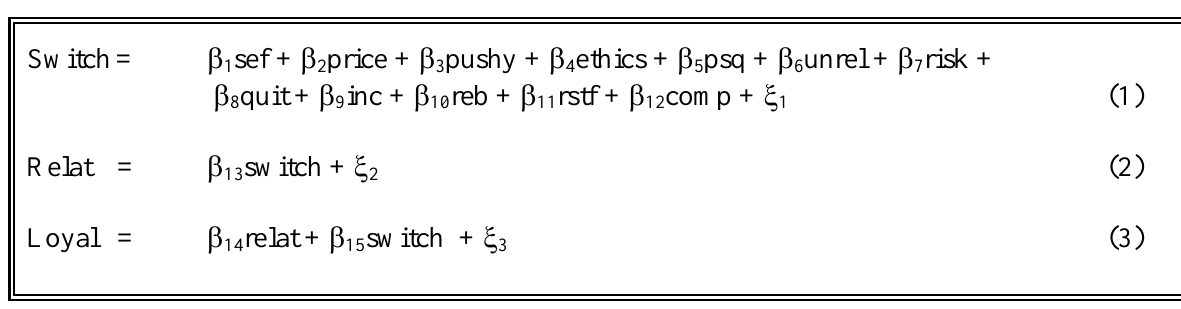
Specification of the structural and measurement model